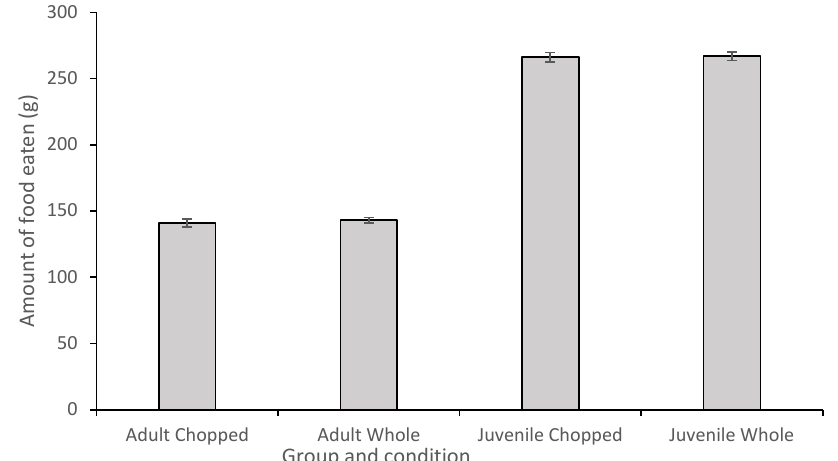
Figure 4. Average amount of food eaten by the adult and juvenile White-cheeked Turacos, +/ − standard error. Table 5. Pairwise comparisons between the amount of food eaten by adult and juvenile birds un- der chopped and whole-food conditions. Significant values are indicated by an asterisk.